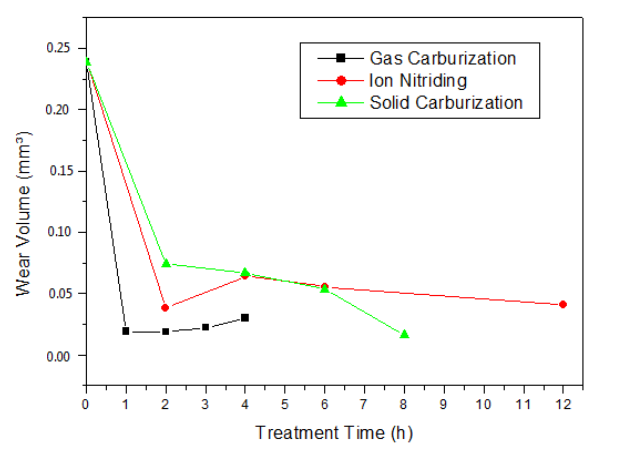
Figure 7 – Wear volume by treatment time for all thermochemical treatments